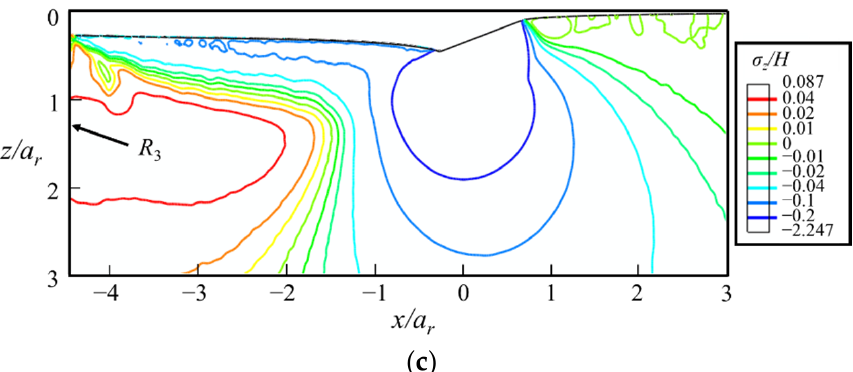
Figure 16. The contours of ( a ) σ x / H , ( b ) σ y / H, and ( c ) σ z / H at the end of the sliding stage ② in the xz - cross-section, where a r = 2.24 h max is the real contact radius evaluated by FEA, and H is the hardness measured by indentation tests. The indenter moves along the positive direction of the x -axis.